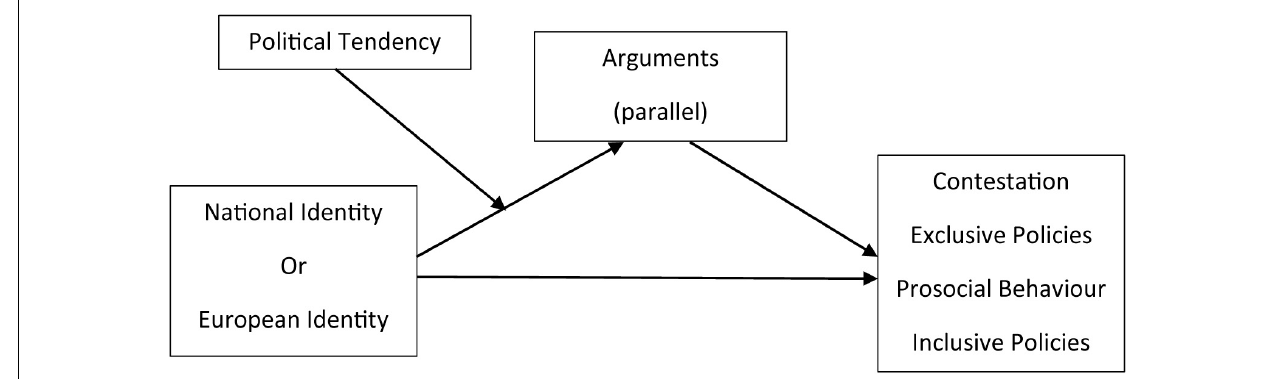
FIGURE 2 | Moderated mediation models (PROCESS 3.3 version, Model 7), taking National Identity or European Identity as predictor, Contestation, Exclusive Policies, Prosocial Behavior and Inclusive Policies, Contestation or Prosocial Behavior as dependent variable, Arguments (Humanitarian; Economic Benefit; Scarce Jobs; Cultural Deterioration; Invasion) as parallel mediators (included in all models) and Political Tendency as the moderator (included in all